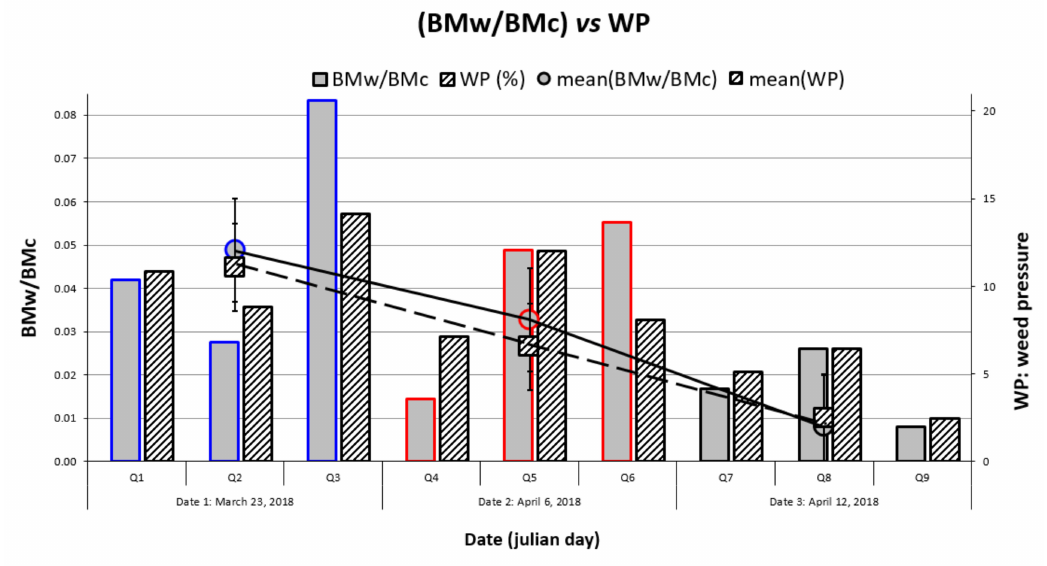
Figure 9. Comparison of the temporal evolution of the BMw / BMc ratio deduced from destructive measurements to WP derived from visible images. The average values (circle mark for BM and square for FVC) and the local values are obtained for each quadrat on the three